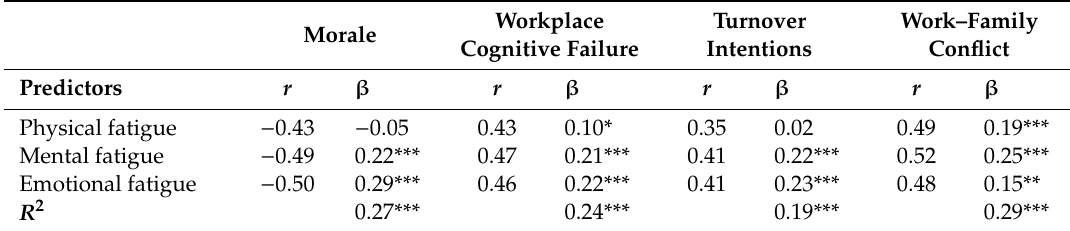
Table 5. Regression of Outcomes on Work Fatigue. Workplace Turnover Work–Family Morale Cognitive Failure Intentions Conflict